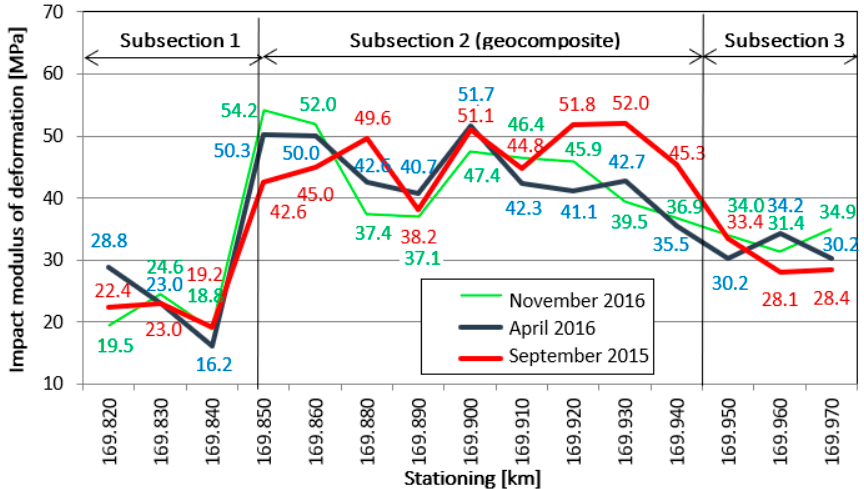
Figure 25. Measurement of modulus along observed track on different sections (adapted from [144]).